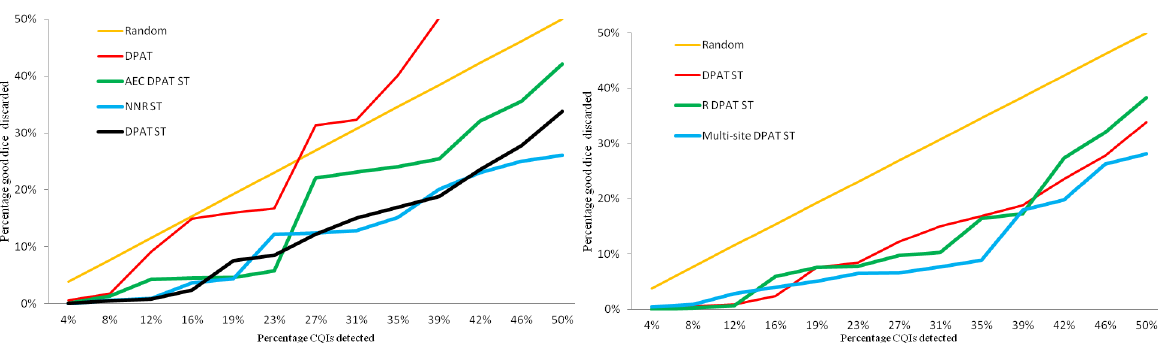
Figure 14. Part Average Testing algorithm